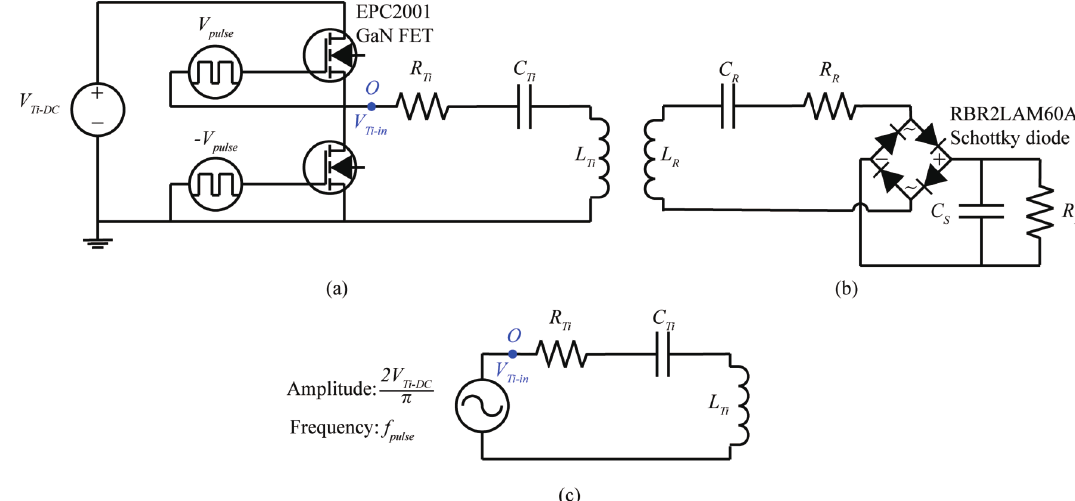
Figure 6. Circuit design for simulation and experiment: ( a ) class-D amplifier for transmitter, ( b ) receiver with full-bridge rectifier and smoothing capacitor, and ( c ) equivalent transmitter circuit of Figure